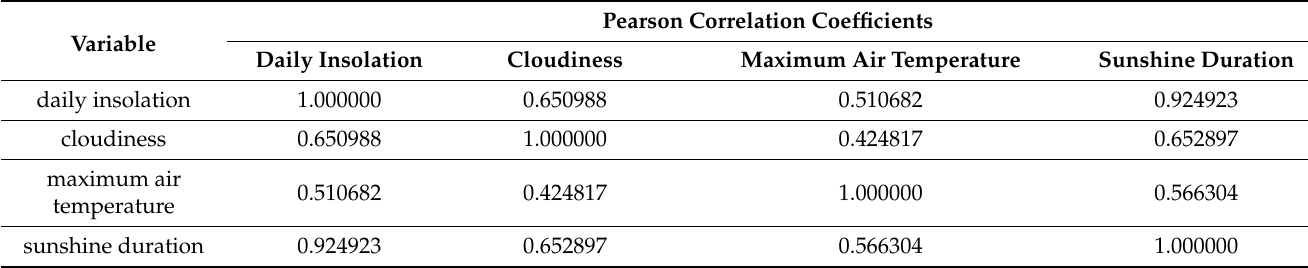
Table 3. The determined correlations between the explanatory